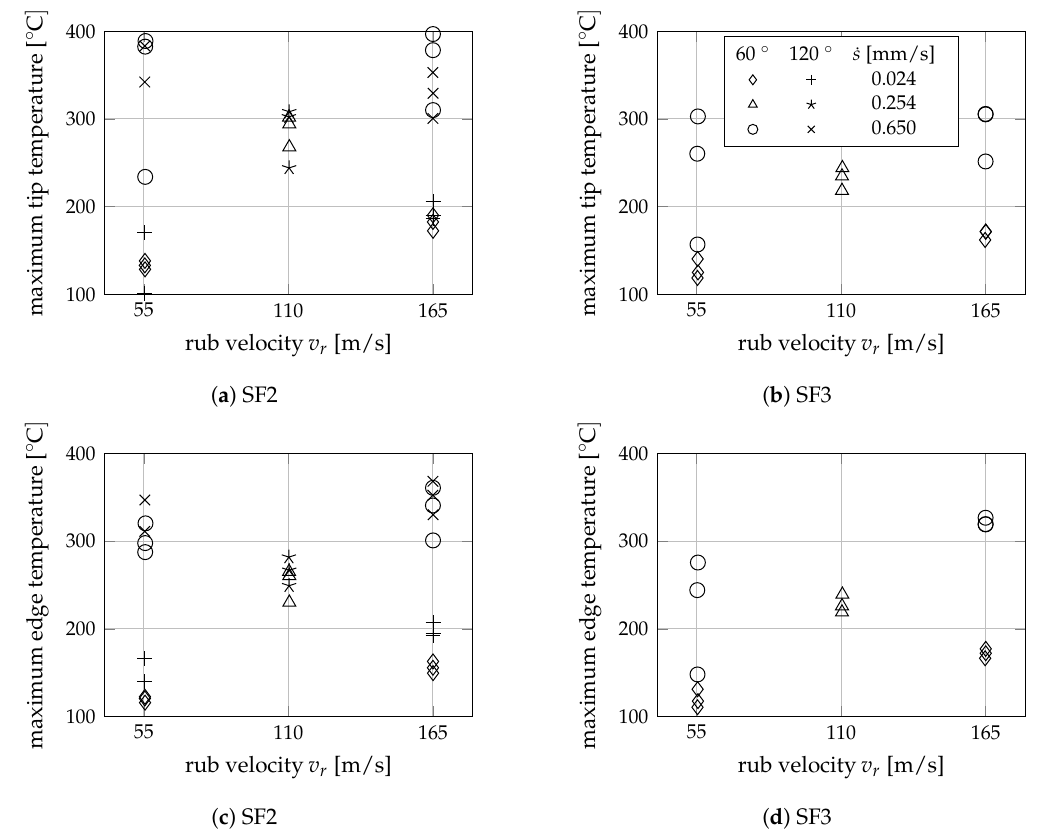
Figure 13. Average maximum foil temperature in the tip region and the left edge for all five rub scenarios with sheet thickness